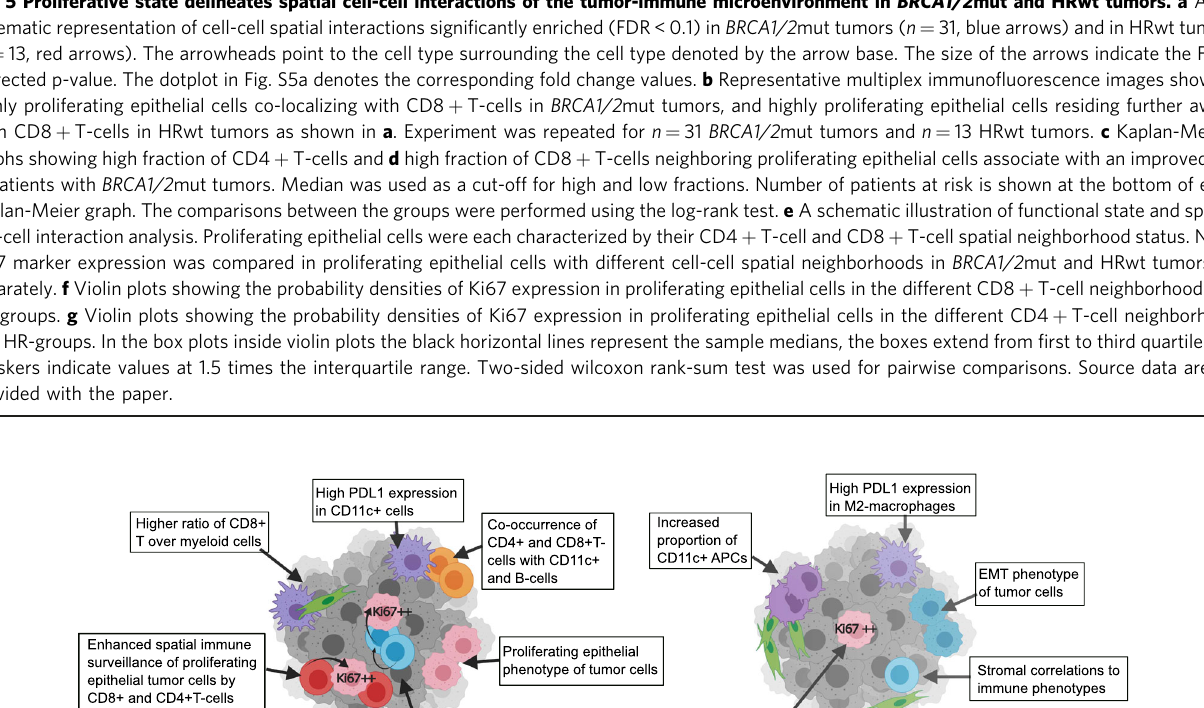
Fig. 6 Graphical summary of the differences in the TME of BRCA1/2 mut and HRwt tumors. A schematic representation of the differences in cell type in fi ltration and their spatial interactions in the BRCA1/2 mut and HRwt tumors, characterized by proliferating epithelial and EMT tumor cells, macrophages and antigen presenting cells, as well as the spatial interactions of CD8 + T-cells and CD4 + T-cells with differently Ki67 expressing proliferating epithelial cells and other immune cells. Curved arrows represent a spatial